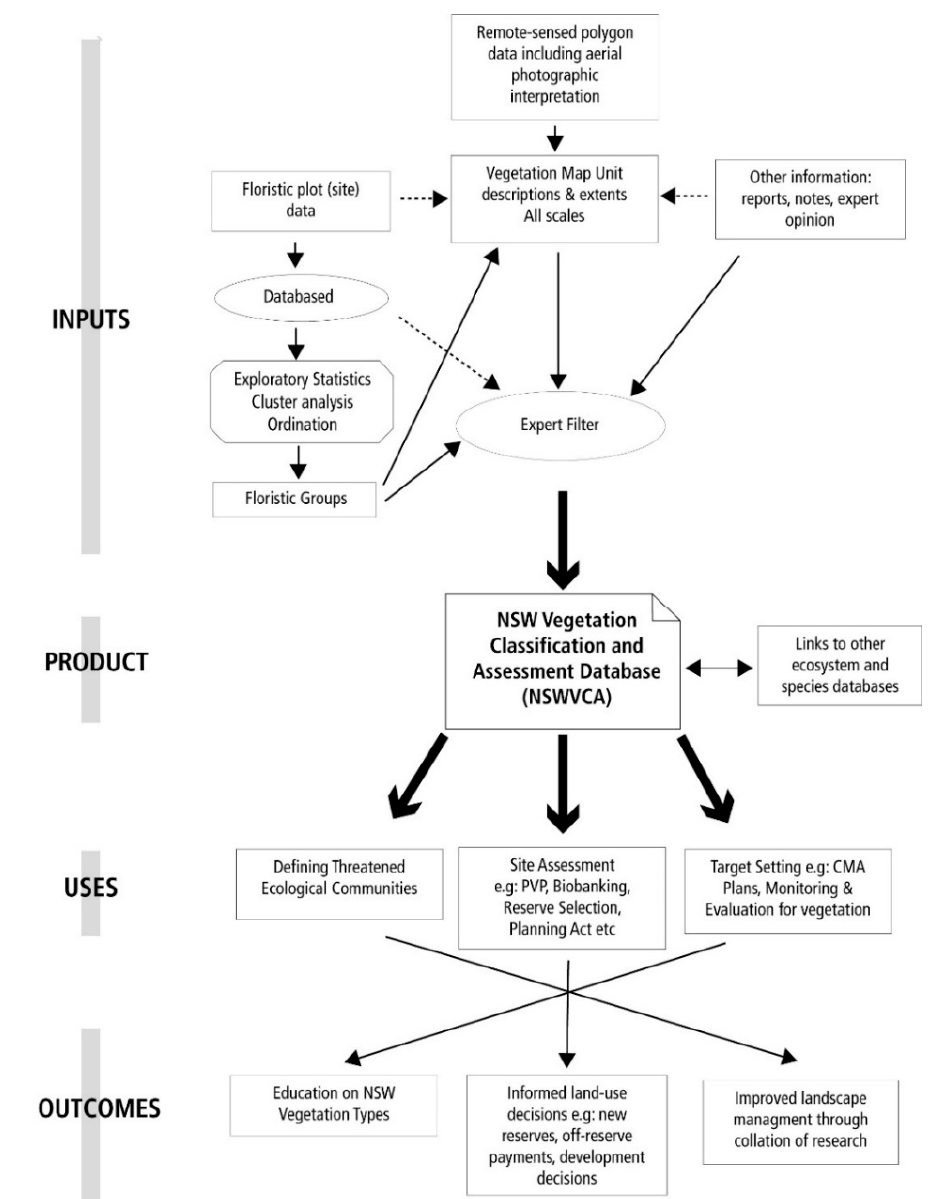
Figure 5. Inputs, uses and outcomes of the NSWVCA project. Rectangles are inputs and outcomes, ovals are processes, truncated rectangle indicates quantitative analysis tools, solid arrows indicate firm paths, hatched arrows weaker paths. Vegetation compositional change caused by land management and climate change will require revision of inputs and products.